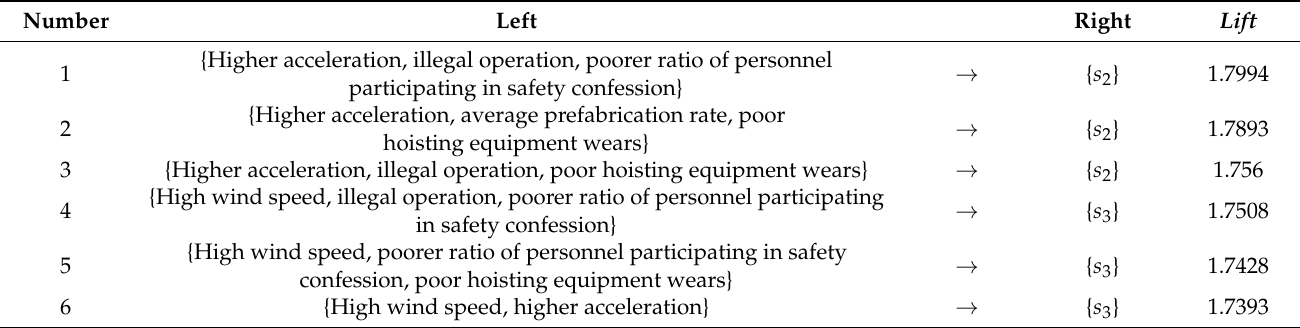
Table 7. Mining results of association rules with higher promotion